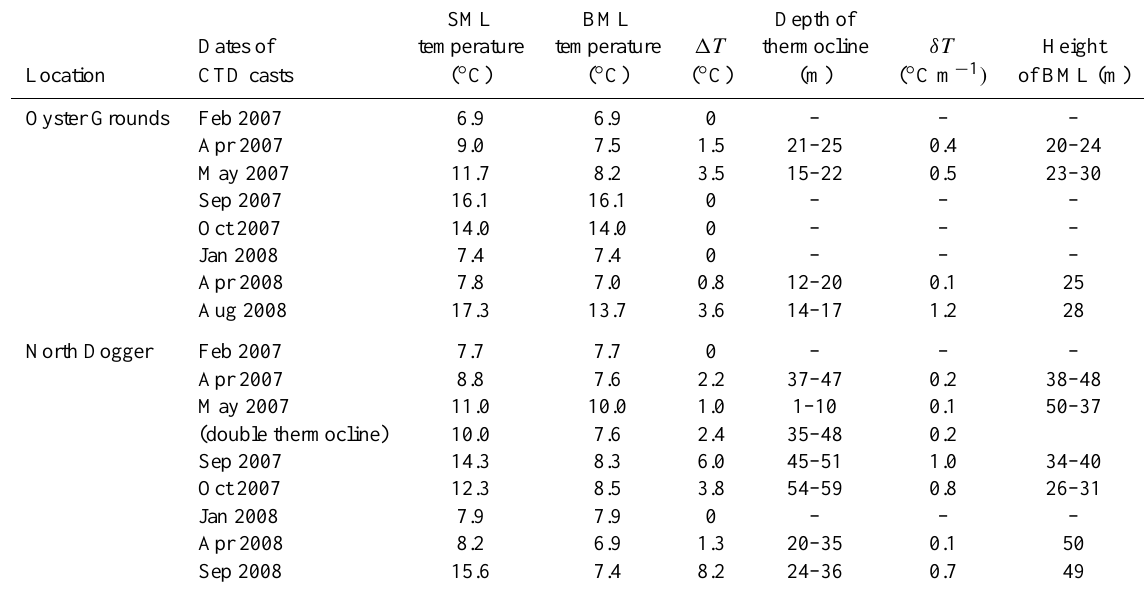
Table 1. Summary of CTD data, averaged for all CTD casts at each site on each cruise. SML is surface mixed layer, BML is bottom mixed layer, 1T is temperature difference between SML and BML, δT is the rate of change of temperature across the thermocline. SML